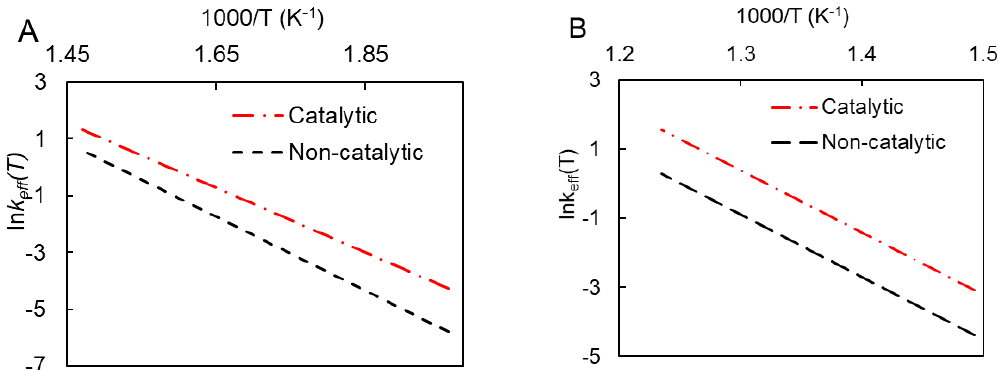
Figure 8. Change in effective rate constants depending on temperature for catalytic and noncatalytic low-temperature ( A ) and high-temperature ( B ) oxidation.